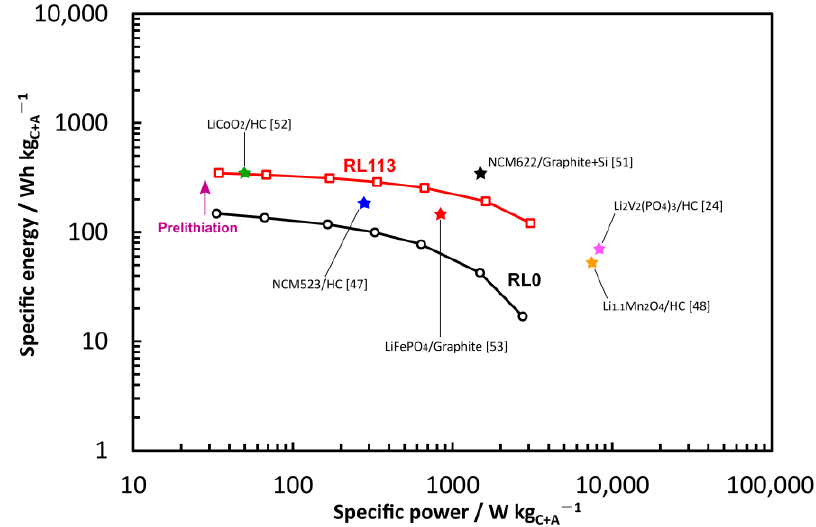
Figure 6. Ragone plots of the NCM523|HC/N-Si cell with optimal full-cell performance and the prelithiation-free cell.